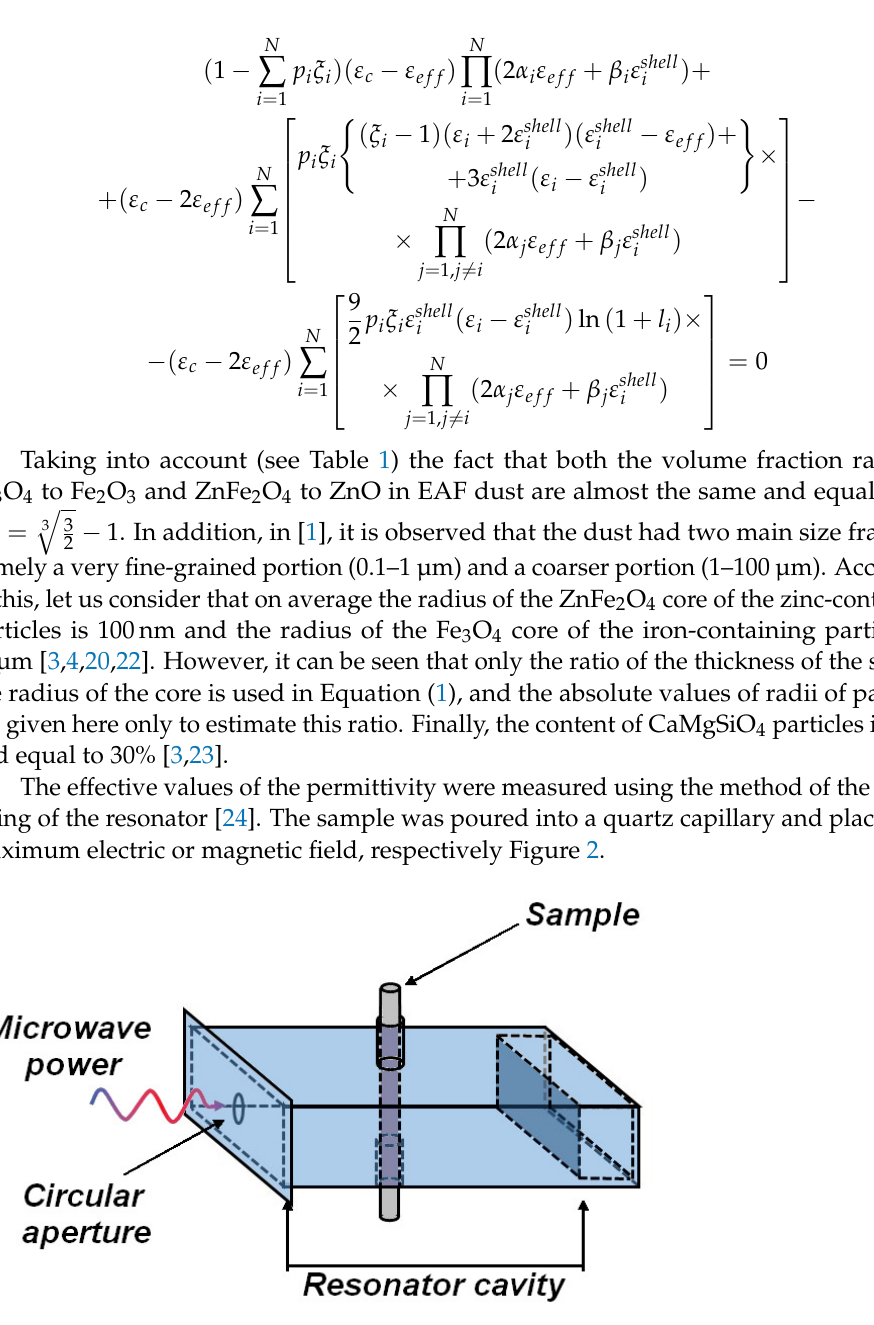
Figure 2. Schematic illustration of the experimental setup for permittivity measurement using the method of the partial filling of the